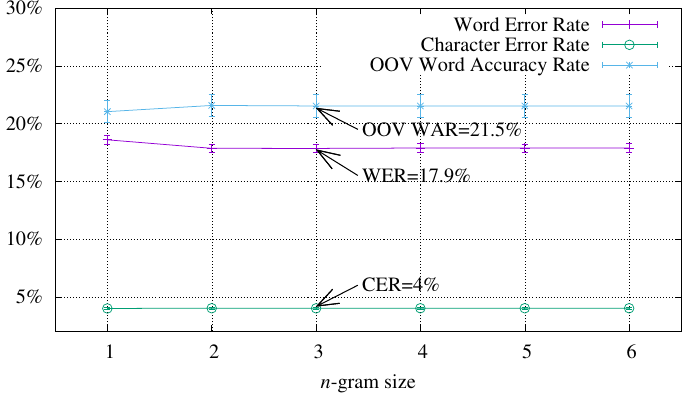
Figure 17. Results obtained by the CRNN word-based system using n -gram language models with size n = { 1, . . . ,6 } .